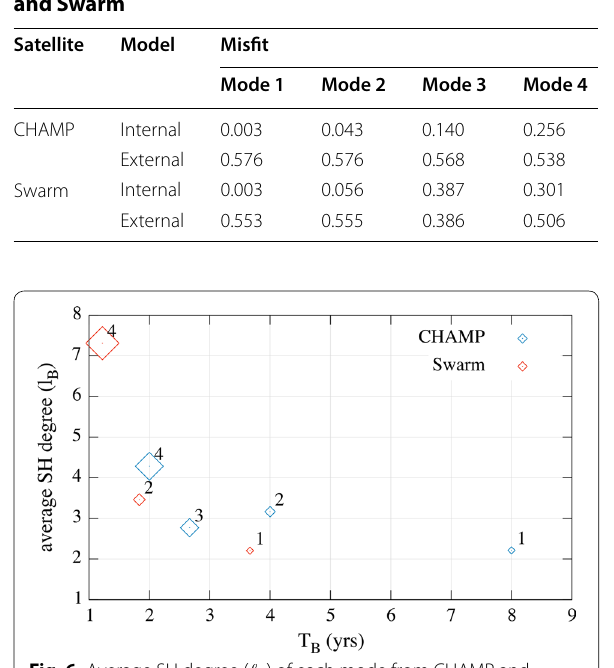
Fig. 6 Average SH degree ( ℓ B ) of each mode from CHAMP and Swarm as a function of the time resolution ( T B ). Size of symbols is proportional to the misfit to an internal field model (Table 1) and numbers next to symbols represent the mode ordering